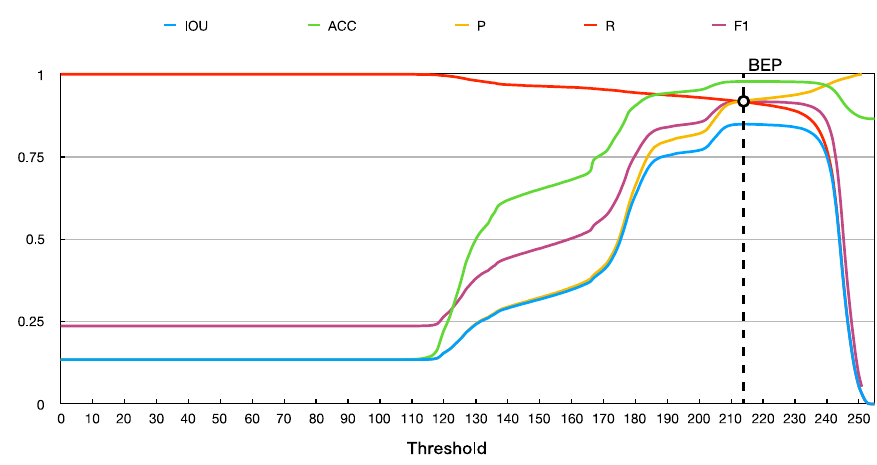
Figure 8. Results of the evaluation indices at each threshold.